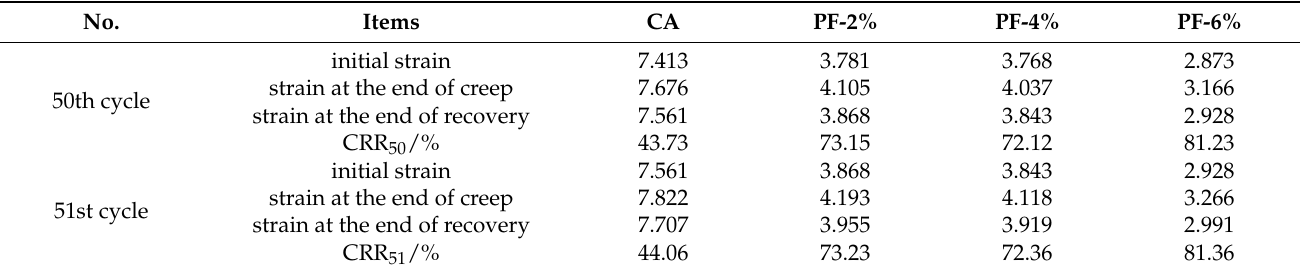
Figure 5. Evolution of strain versus time for composites with brucite fiber in the 50th and 51st cycles. (left Y -axis: CA, as indicated by the black arrow; right Y -axis: BF-2%, BF-4%, and BF-6%).